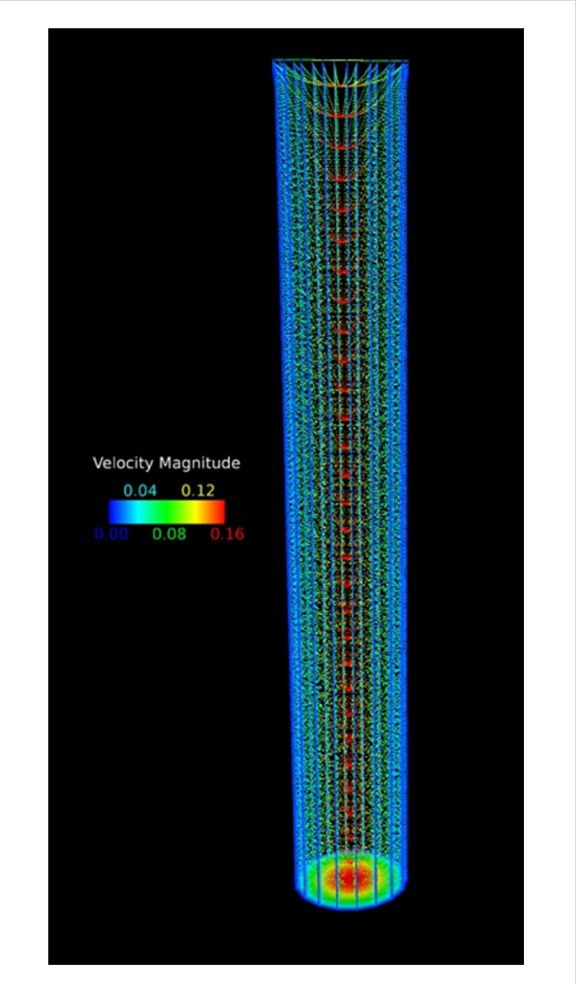
Figure 10: Velocity profile of NPs flowing through the hydrogel channel using